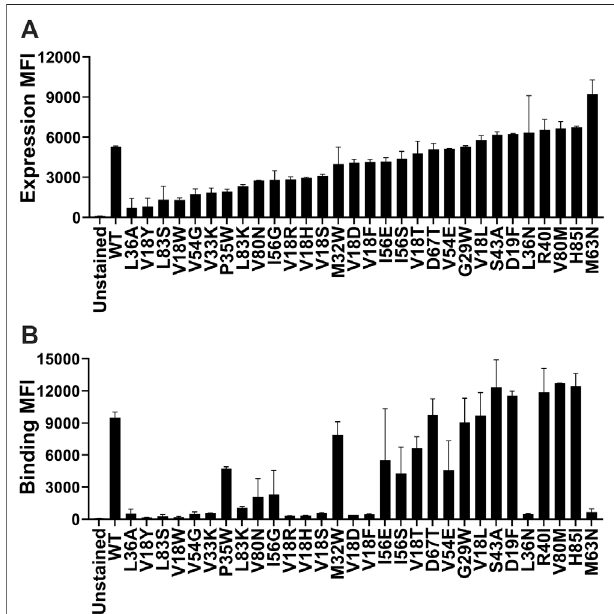
FIGURE 1 | Comparison of the level of expression and binding of CcdB mutants on the yeast cell surface. (A) The expression and (B) binding to GyrA14 of individual mutants. Errors are calculated from two biological replicates. Most mutants expressed at high levels, however, the amount of active protein varied widely. A few mutants which showed a high level of expression did not show any binding to GyrA14. In both panels, mutants are arranged in order of increasing expression